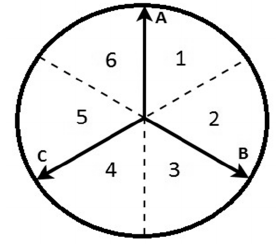
Figure 3. Schematic of a brushless DC motor. Table 1 . PWM values to determine the area of the vector in above Figure 3.